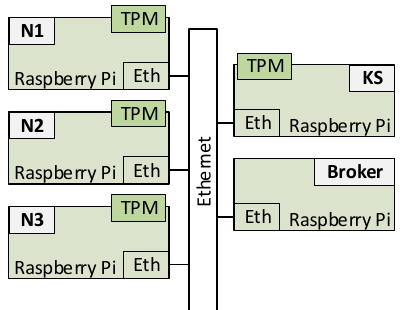
Figure 35. Raspberry Pi 3B+ with LetsTrust TPM v.2.0.